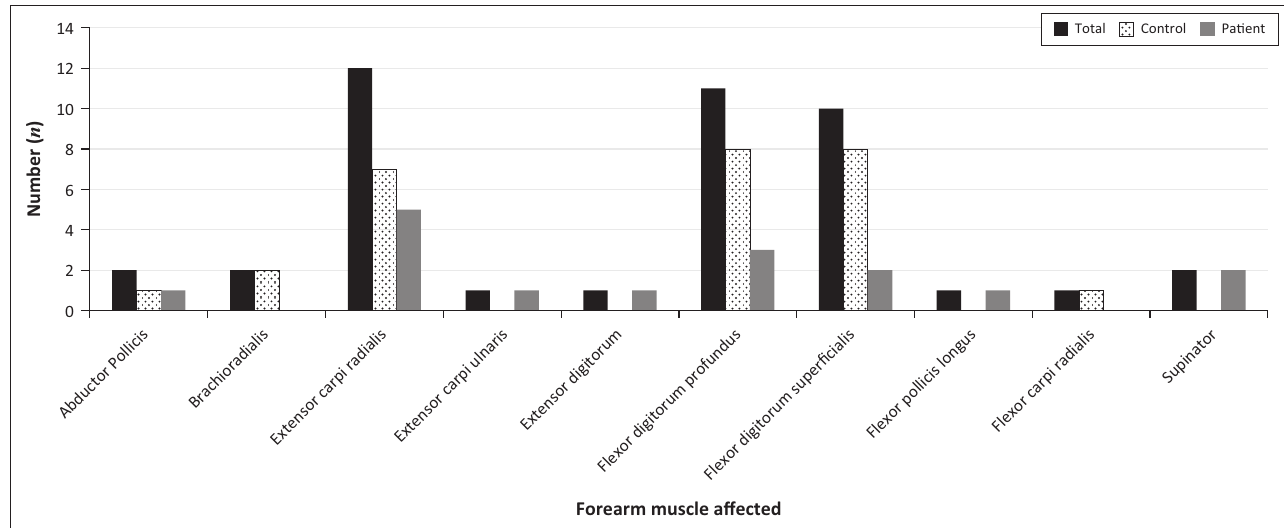
FIGURE 1: Individual muscles involved per TABLE 3: Number of muscles involved by sex and arm. Demographic parameter